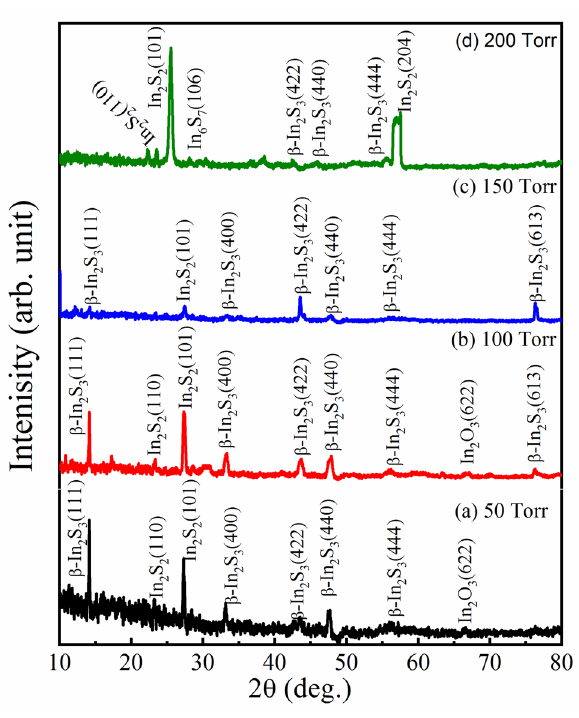
Figure 3. ( a – d ): The XRD patterns of the grown thin film of In 2 S 3 at annealing temperature 550 °C with different pressures ( a ) 50 Torr ( b ) 100 Torr ( c ) 150 Torr, and ( d ) 200 Torr.